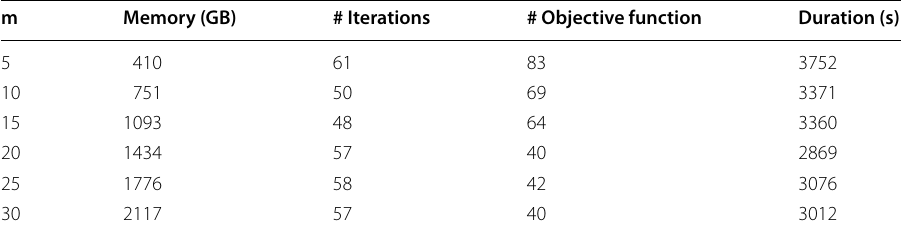
Table 3 Results description for lshtc‑large dataset